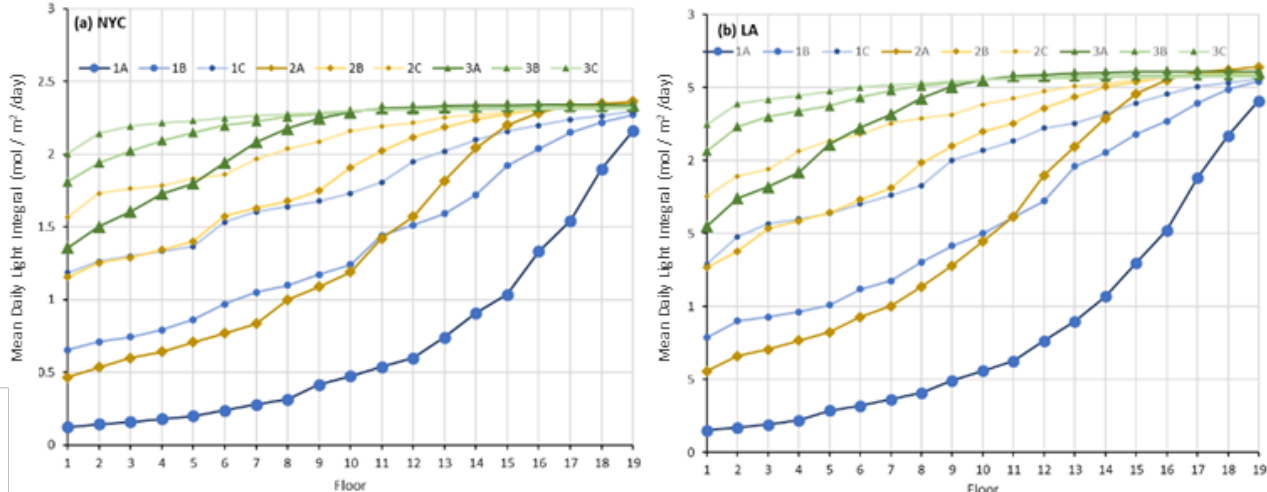
Figure 6. Mean daily light integral (DLI) (mol · m − 2 · day − 1 ) for each level of a skyscraper farm in NYC ( a ) and LA ( b ) under different urban scenarios. Details of urban scenarios are described in Table 2.